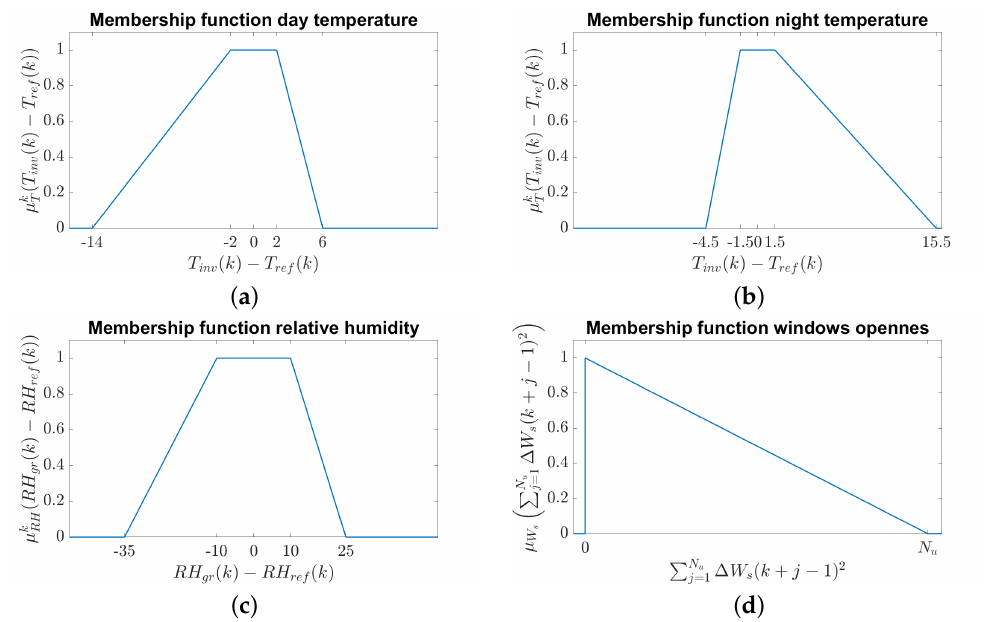
Figure 3. Membership functions. ( a ) Daytime temperature; ( b ) night-time temperature; ( c ) relative humidity; ( d ) total window